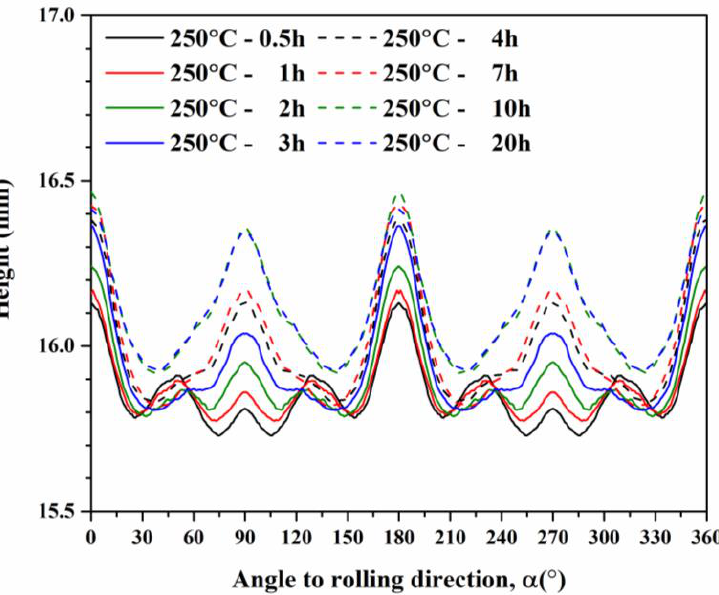
Figure 2. Cup height profiles of deep-drawn AA5151 alloy as a function of the angle calculated from experiment results at 250 °C for 0.5, 1, 2, and 3 h.